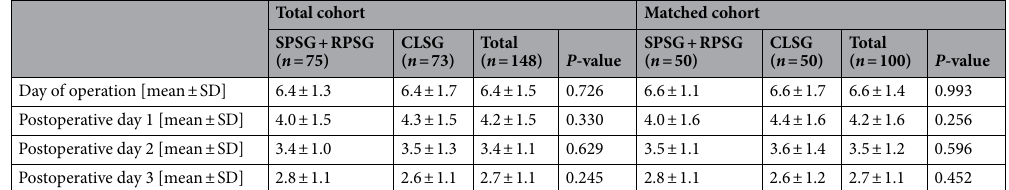
Table 6. Postoperative pain NRS score in the total and propensity score-matched cohorts. NRS numeral rating scale, SPSG single-port sleeve gastrectomy, RPSG reduced port sleeve gastrectomy, CLSG conventional laparoscopic sleeve gastrectomy, SD standard